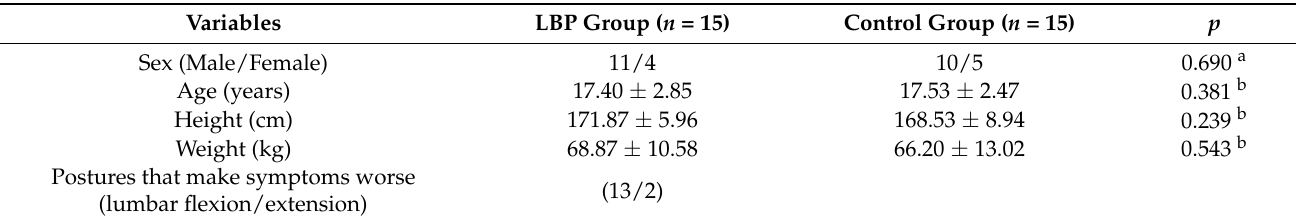
Table 1. General characteristics of participants ( N = 30).